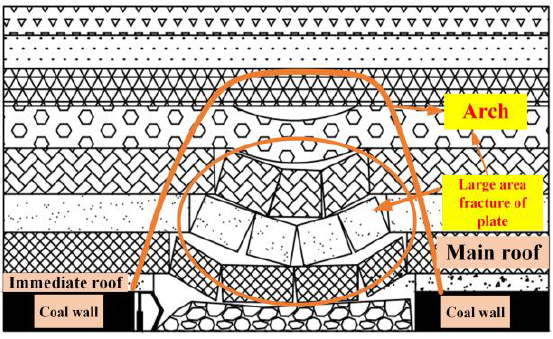
Figure 4. Full mining.